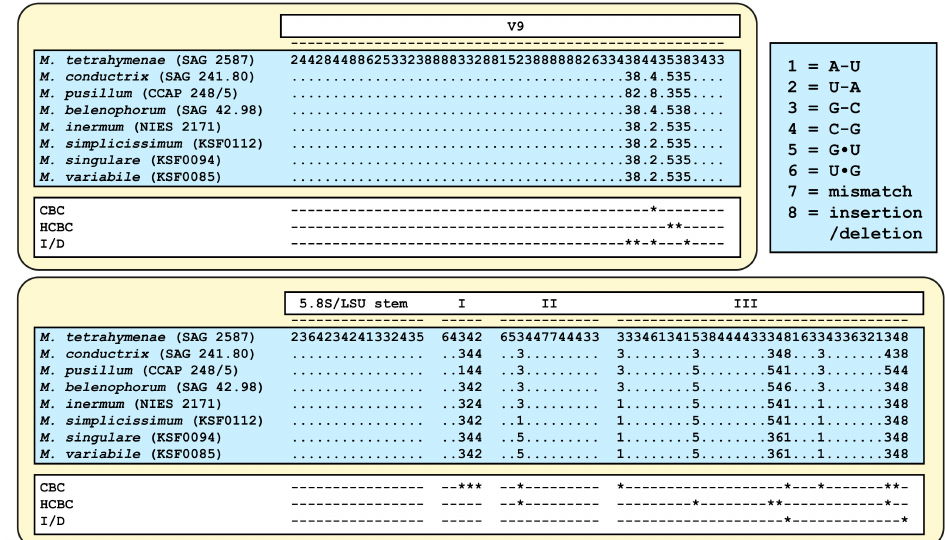
Figure 7. Variability of ITS-2 among the eight Micractinium species. The characteristic features within the conserved regions are highlighted in white